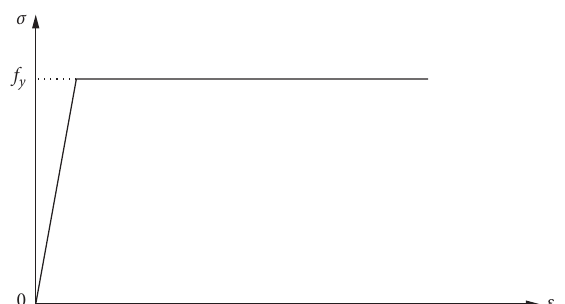
Figure 2: Bilinear stress-strain relationship for steel